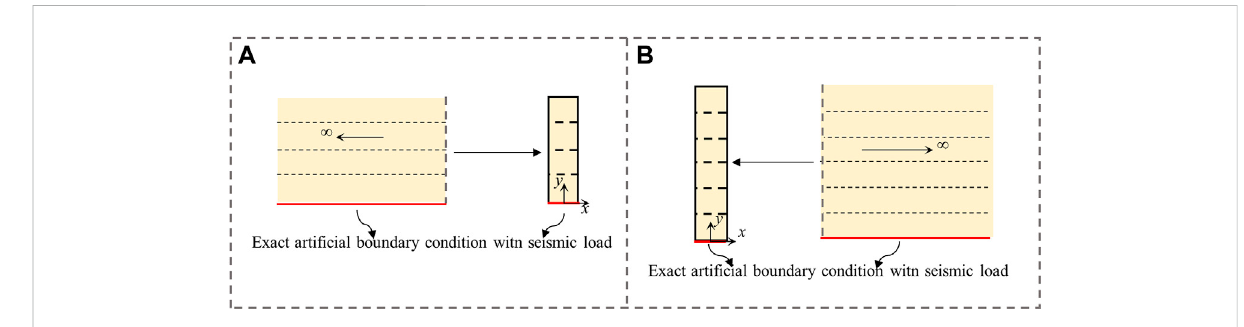
FIGURE 2 One-dimensional fi nite element model. (A) Left boundary. (B) Right